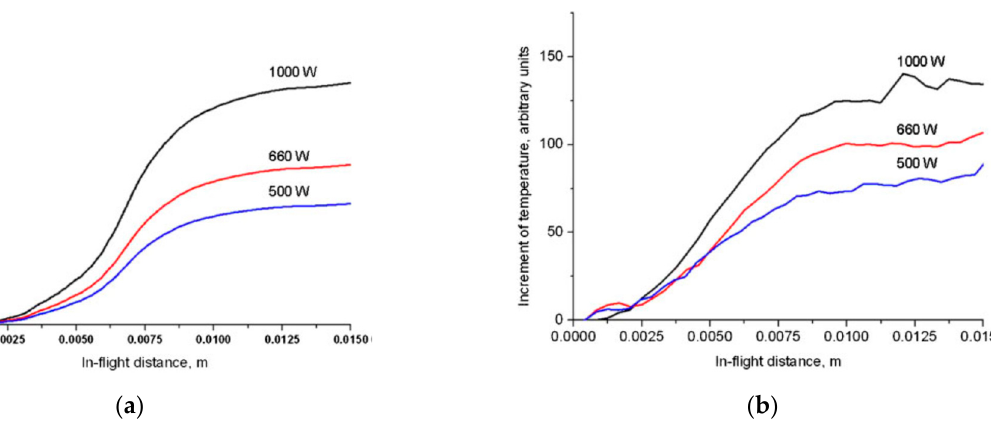
Figure 15. ( a ) Numerical and ( b ) experimental temperature of the powder at different laser powers (reproduced with permission from [54]; Copyright © 2011 Taylor &